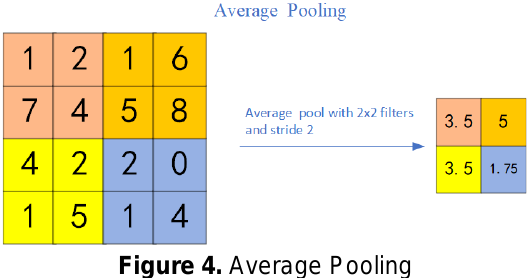
Figure 4. Average Pooling